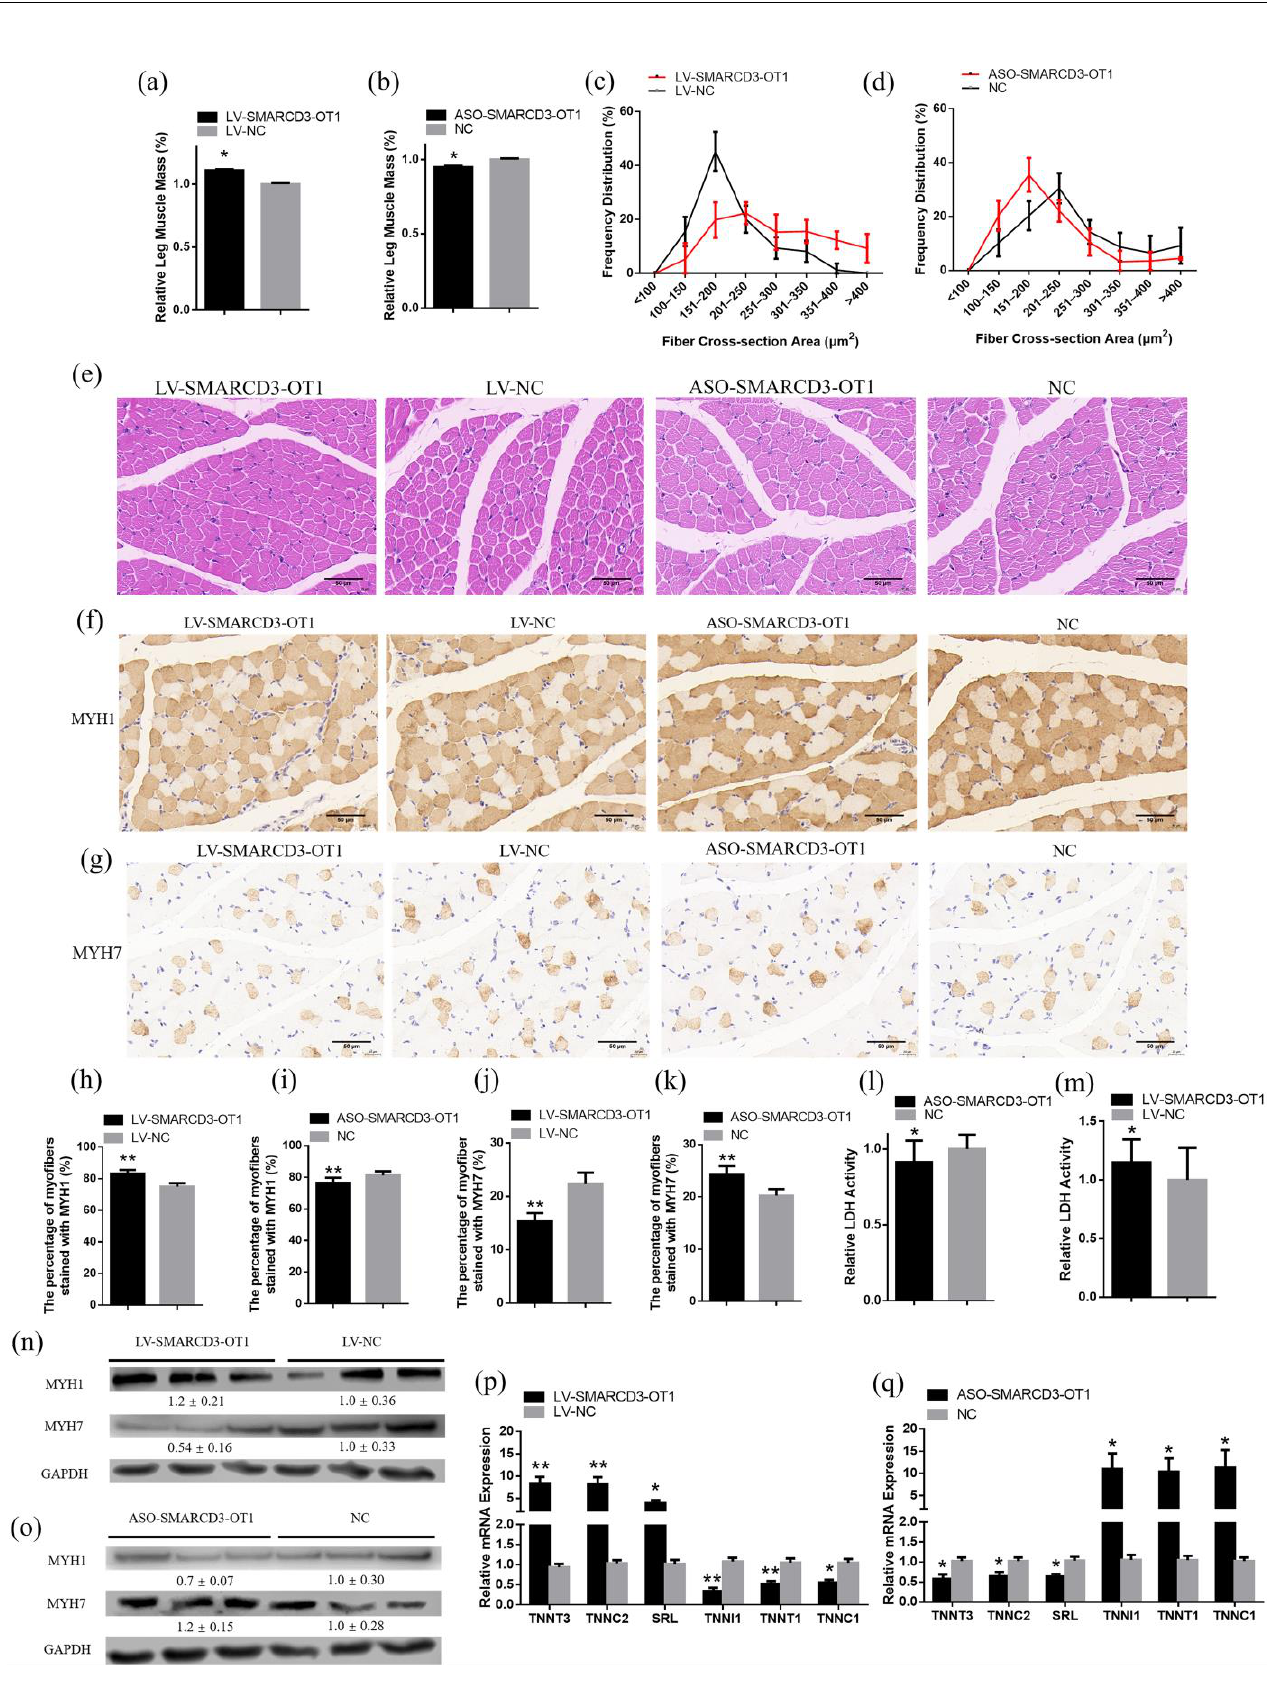
Figure 8. SMARCD3-OT1 positively regulates muscle development and improves muscle hypertrophy and myofiber transformation. ( a , b ) Relative mass of gastrocnemius muscles after injection with overexpression or knockdown of SMARCD3-OT1 in vivo ( n = 15). ( c – e ) H&E staining and frequency